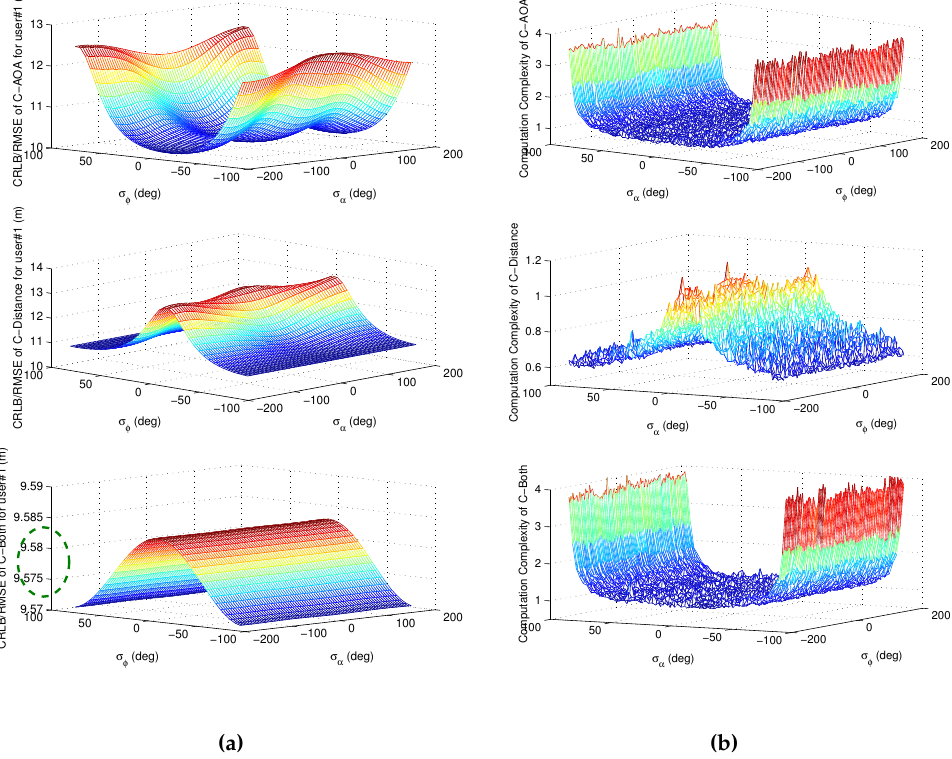
Figure 10. The impact of user distribution on positioning accuracy and computation complexity. ( a ) The positioning accuracy of user #1; ( b ) the average elapsed time of collaborative